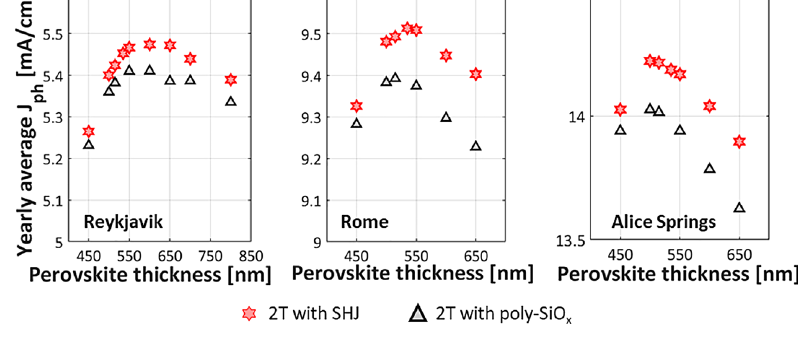
Figure 6: Yearly average photocurrent density of mono-facial 2T tandems with SHJ bottom cell (red stars) or c-Si bottom cell passivated with poly-SiO x (grey triangles) forvaryingperovskiteabsorberthicknessin (a) Reykjavik (Iceland), (b) Rome (Italy) and (c) Alice Springs (Australia).